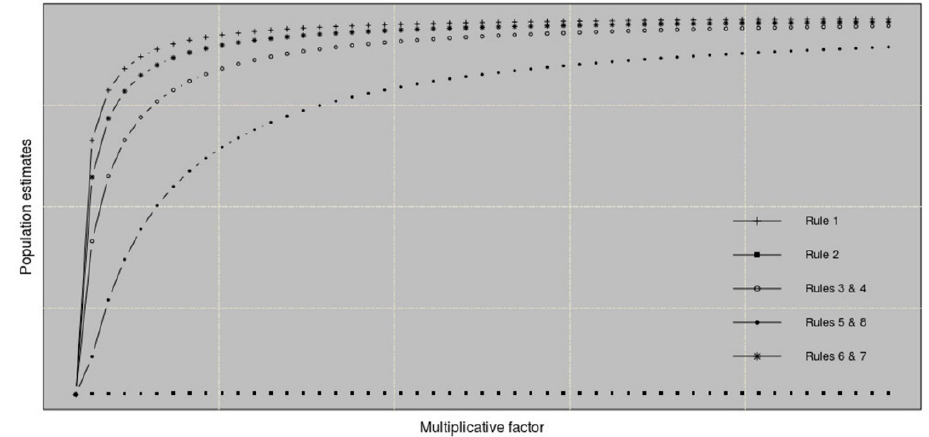
Figure 9. Results of the Monte Carlo simulation.